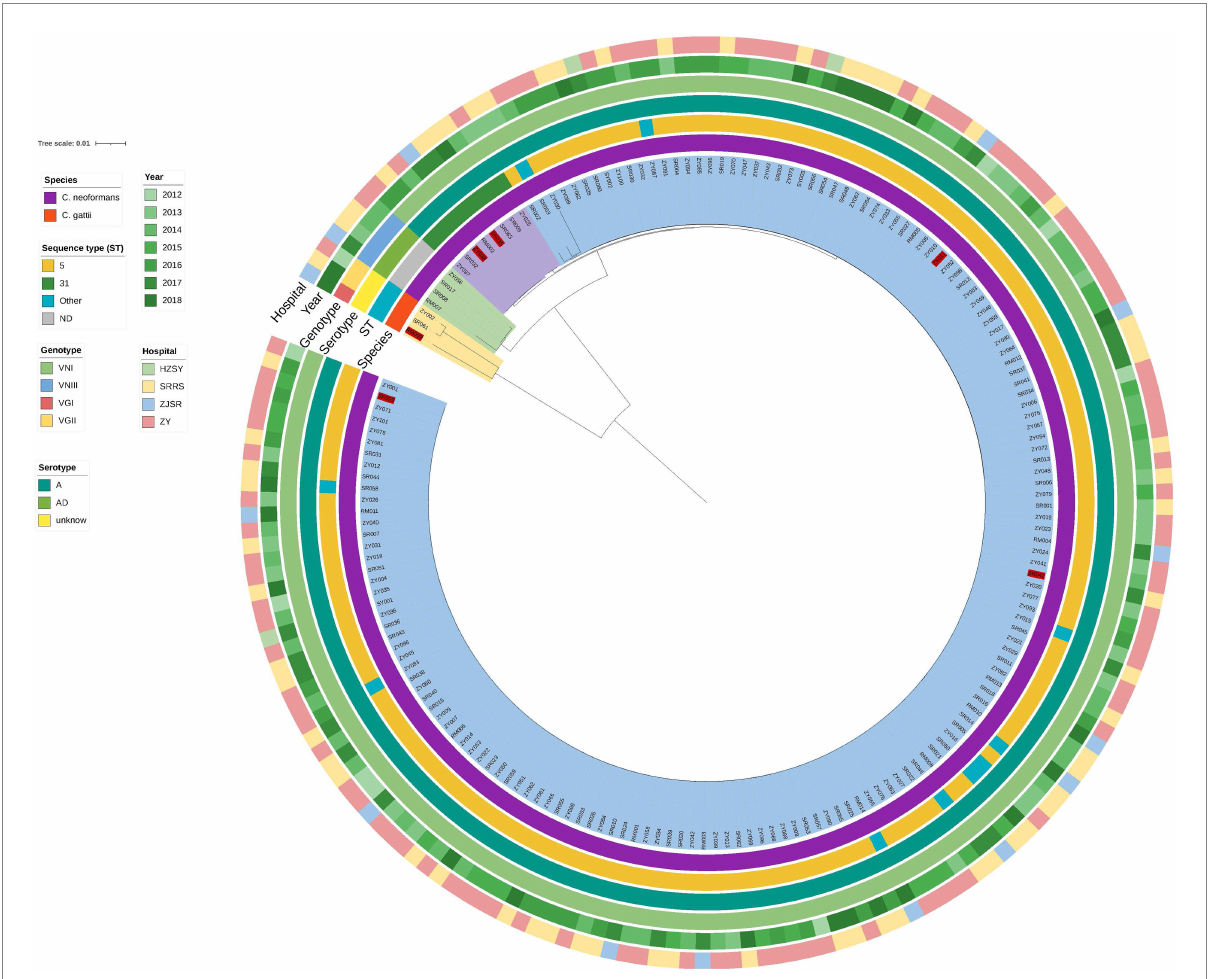
FIGURE 2 Phylogenetic tree of 180 isolates based on WGS. The innermost circle is the phylogenetic tree based on WGS. All strains were classified into two large clusters. The cluster indicated in yellow (corresponding to the bright orange of the “species” in the first circle) represents the CGSC s , and the other (corresponding to the dark purple of the “species”) represents C . neoformans . The red labelled strains represent strains with high MICs. The second, third, and fourth circles correspond to the sequence type (ST), genotype and serotype, respectively. The cluster of CGSC s contains three strains, RM009-ST215-VGI- α , SR061-ST552-VGII- α , and ZY002-ST328-VGII- α , and these molecular types were significantly different from C . neoformans . In the C . neoformans cluster, the strains were divided into three clusters (green, purple, and blue); the cluster indicated in green had four hybrids, RM007-VNIII-A α Da, ZY056, SR008, and SR017, which were all VNIII-AD- α ; the cluster indicated in purple had 8 strains, all of which were ST31-VNI-A- α ; the large cluster, which is represented in blue, had 165 strains, including ST5 ( n = 155, the dominant ST), ST79 ( n = 5), ST81 ( n = 3), and ST359 ( n = 2), all of which were VNI-A-MAT α . The isolation year (the fifth circle) and hospital (the sixth circle) showed a scattered distribution, and no significant difference in the corresponding strain species was